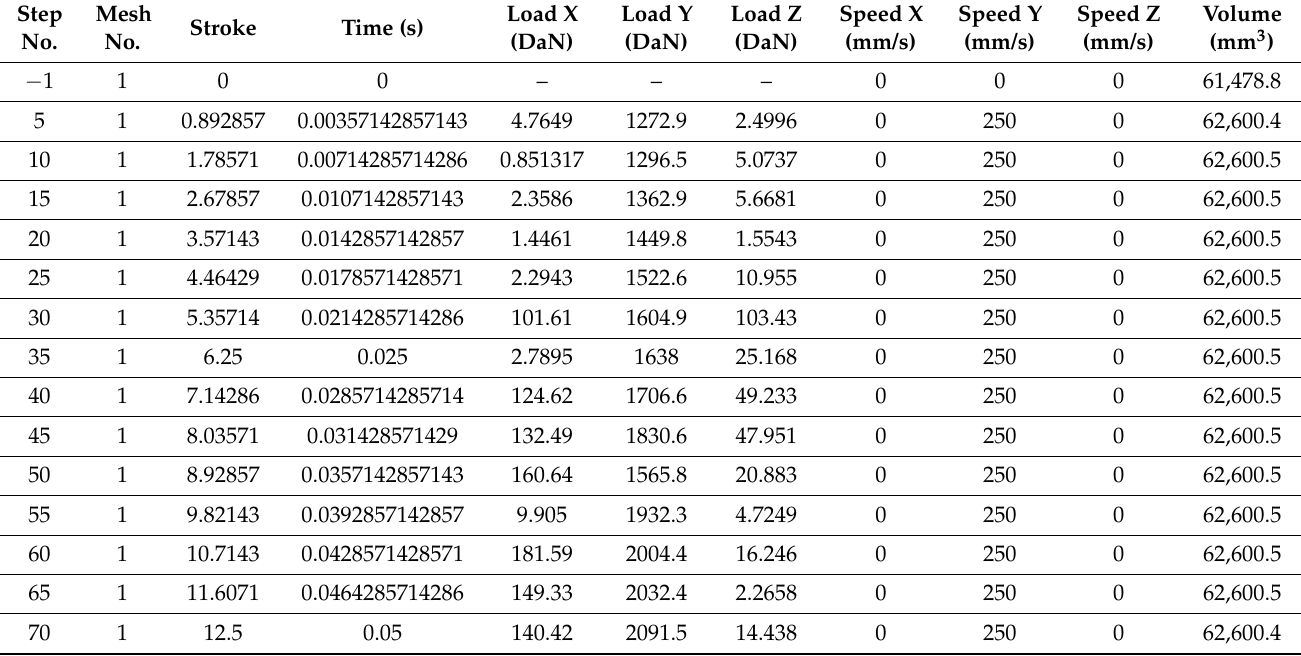
Figure 8 present the variation on the three axes of the displacement field on the composite structure following the